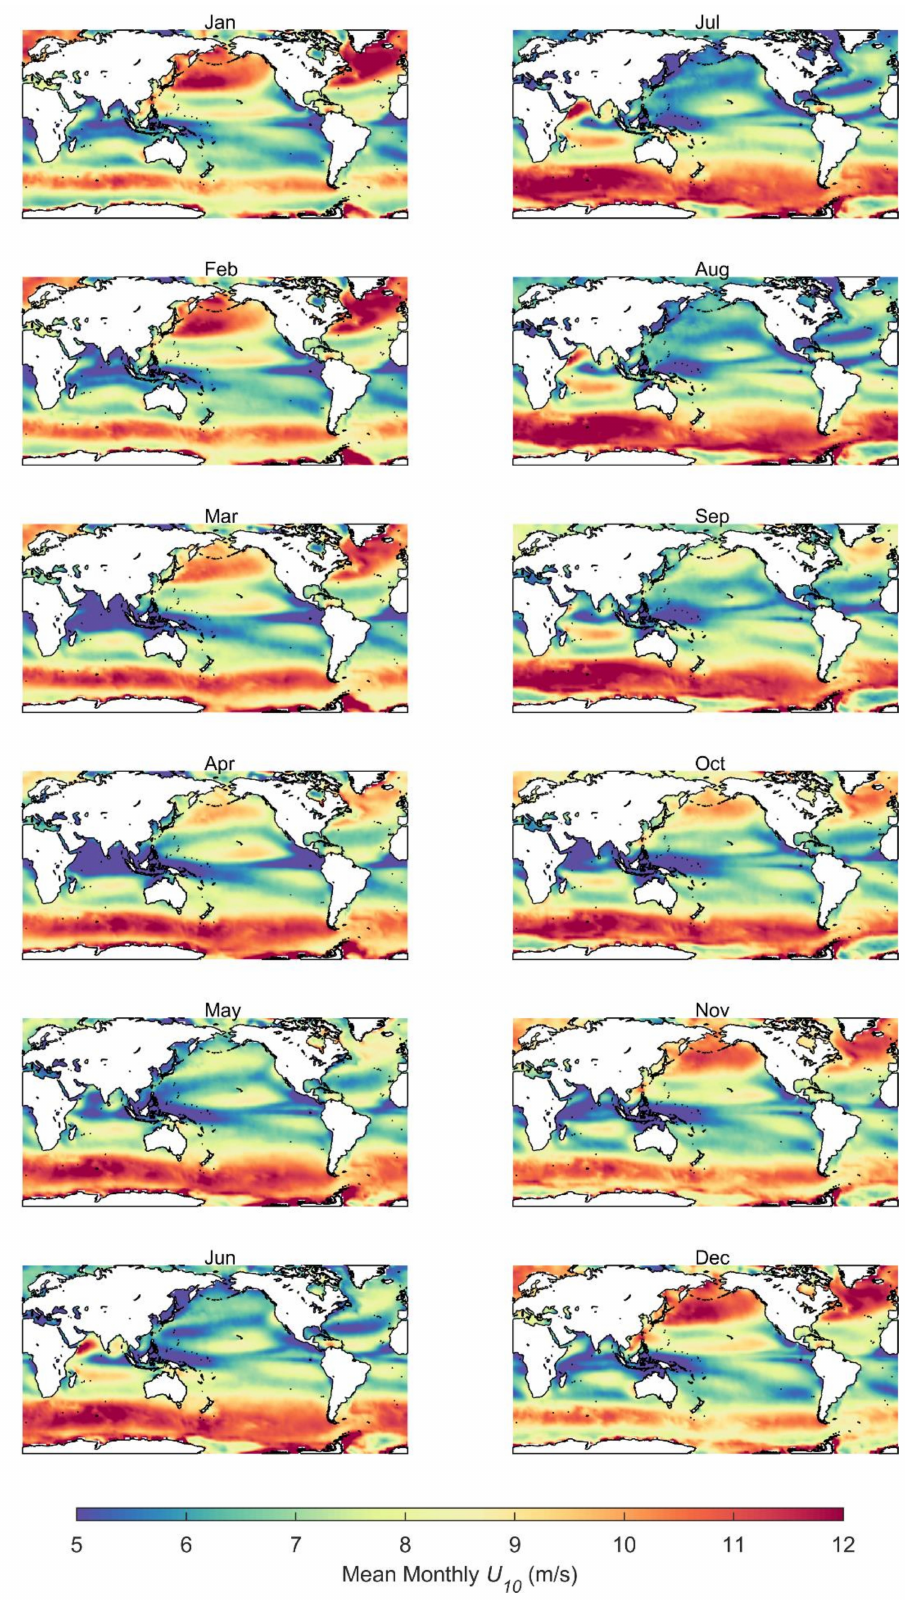
Figure 2. Mean global monthly wind speed at a reference elevation of 10 m ( U 10 ) from scatterometer data, U 10 . The data were gridded at 2 ◦